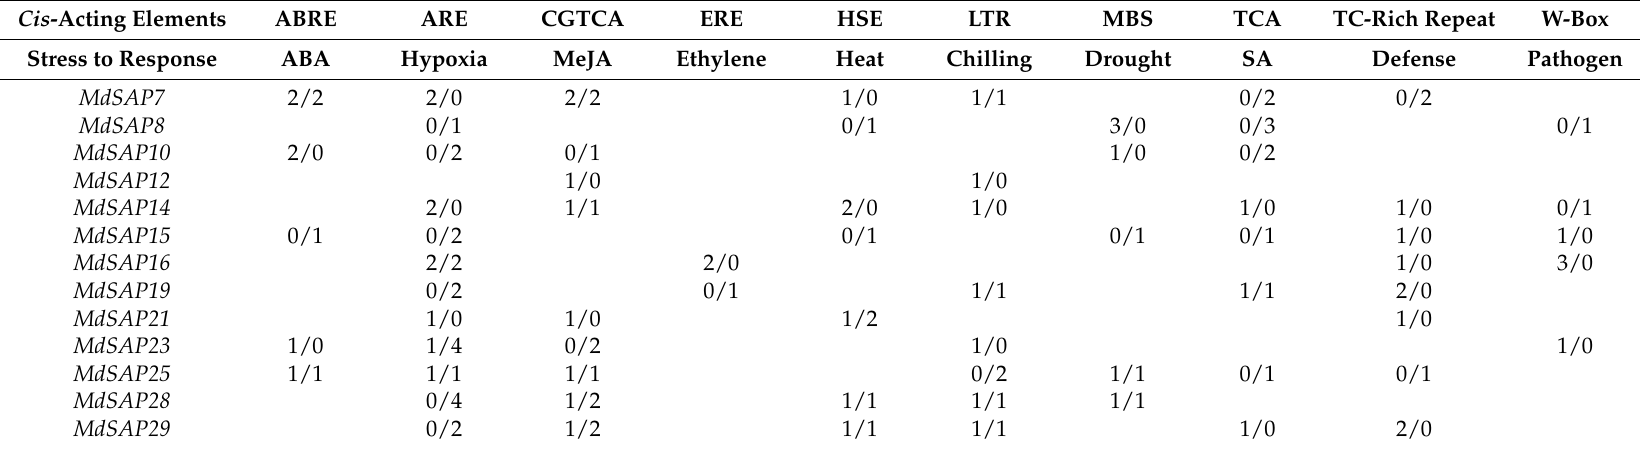
Table 2. The cis -acting elements of 13 promoters in apple SAP